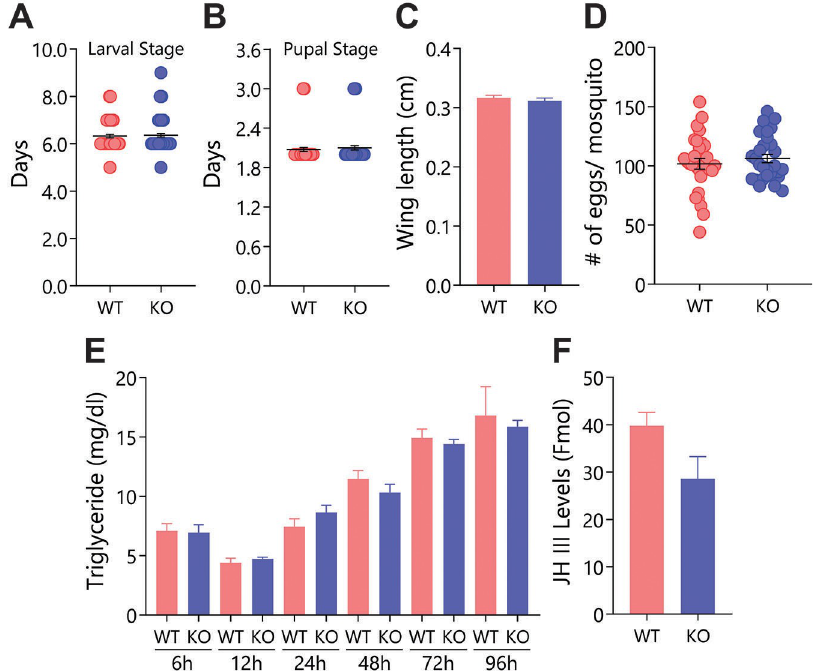
Fig 2. Effect of mJHBP deficiency on developmental and reproductive aspects in Wild Type ( WT ) and mJHBP -/- ( KO ) lines. A. Mean time to pupation (days) from egg hatching (day 0) to the onset of pupation for WT and KO mosquitoes (4 biological replicates of 20 larvae). B. Mean duration of the pupal stage (days) for WT and KO mosquitoes (4 biological replicates of 20 pupae). C. Mean wing lengths ( ± SEM) for WT (n = 30) and KO (3 biological replicates of 10 adults) female mosquitoes. D. Mean number of eggs ( ± SEM) laid by WT and KO females (3 biological replicates of 9–10 adults). E. Quantification of triglyceride levels in WT and KO in newly emerged adult females (6 h, 12 h, 24 h, 48 h, 72 h and 96 h post adult emergence) (2 biological replicates of 2 mosquitoes for each time point). F. Mean JH III levels ( ± SE) in WT and KO mosquito hemolymph quantified by mass spectrometry (5 biological replicates, of 5 mosquitoes). None of these characteristics differed significantly (p � 0.05) between WT and KO lines (Mann-Whitney U